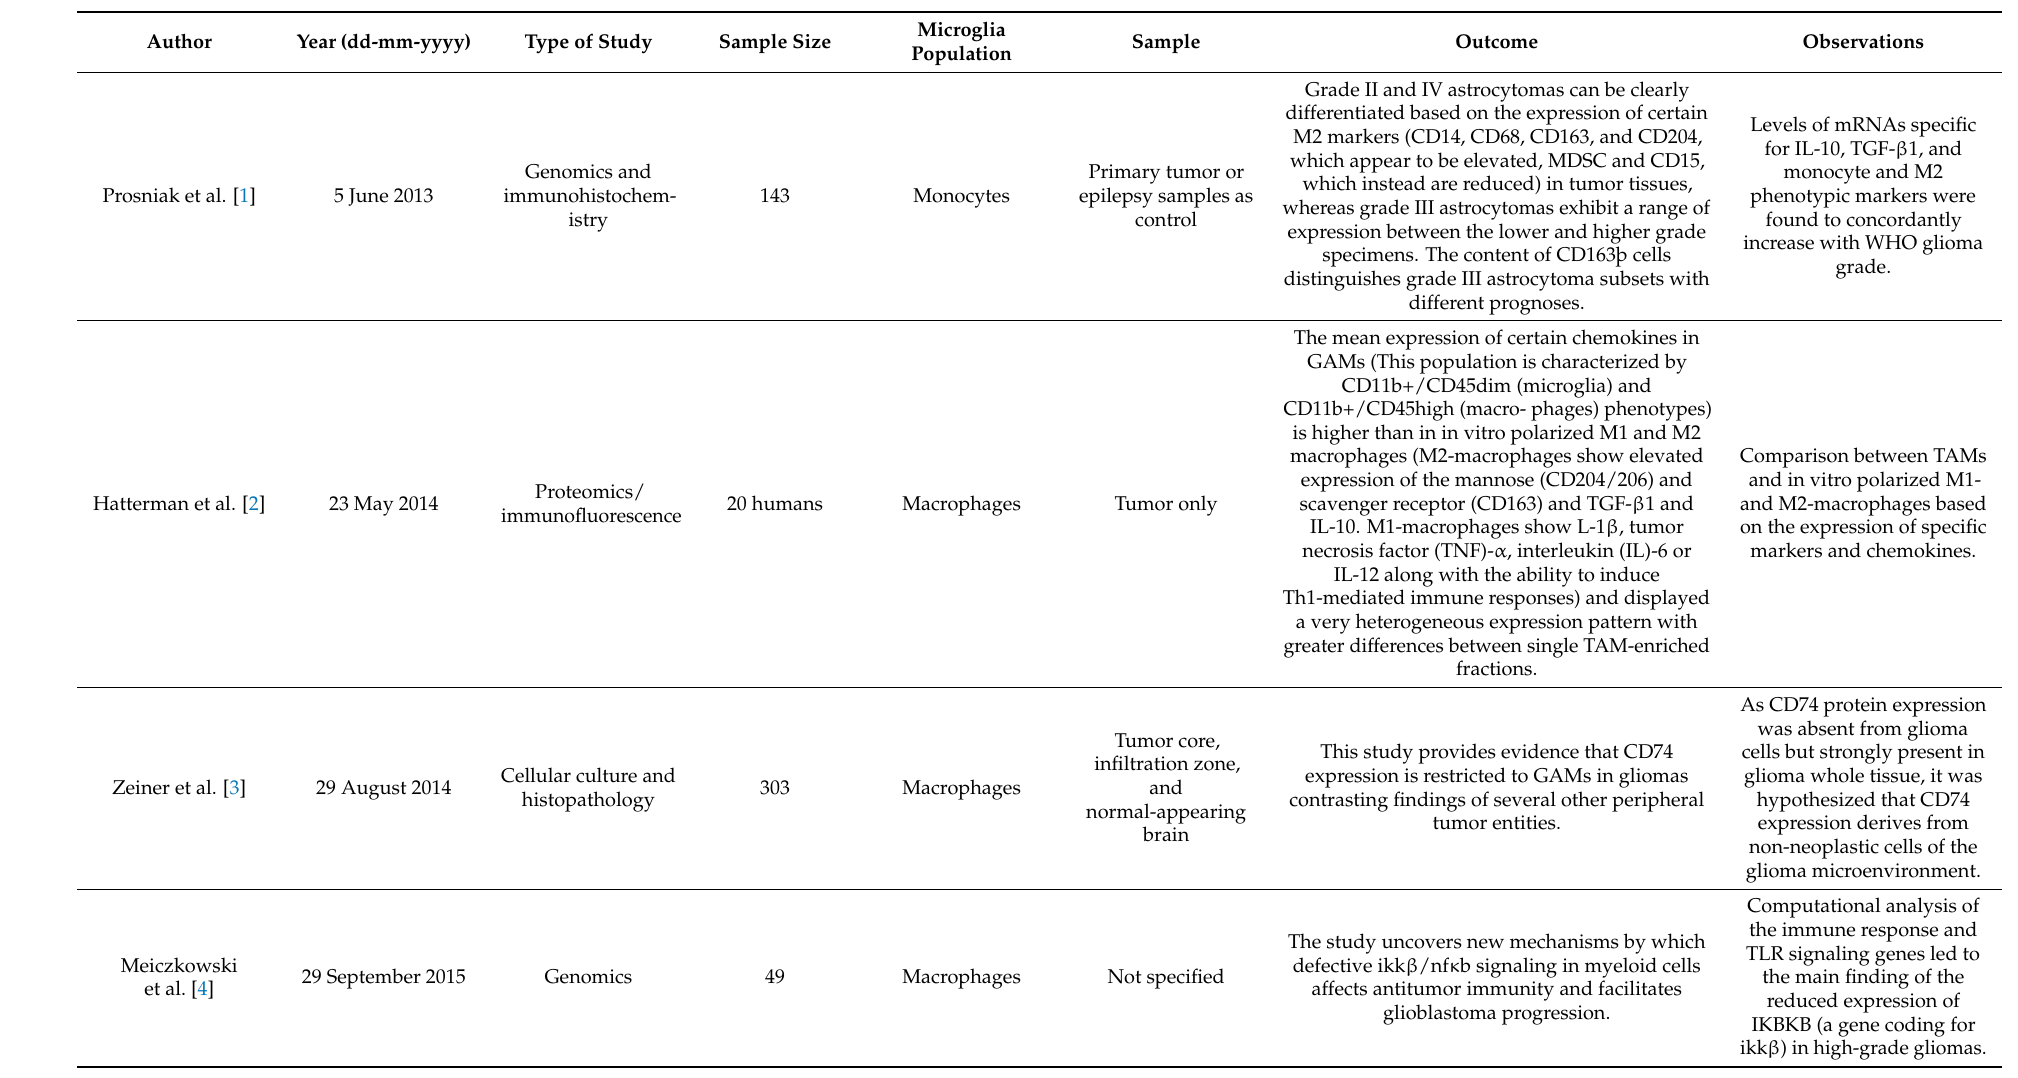
Table 1. Microglia maintenance of immunological homeostasis and protection against